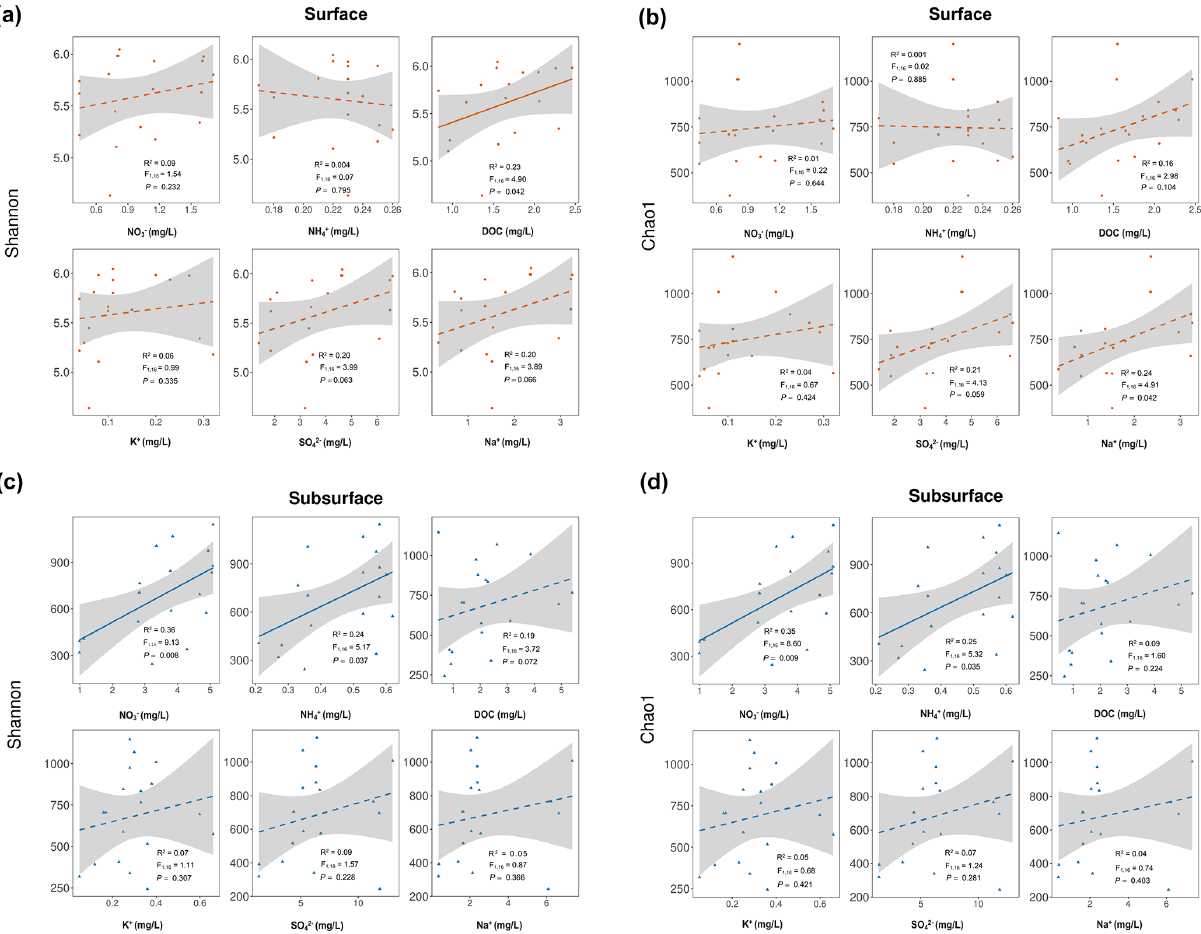
Figure 4. The influence of environmental factors on bacterial diversity. Correlations of Shannon (a, c) and Chao1 (b, d) diversity indices with environmental factors in the surface and subsurface layers. Each dot represents an individual sample. The solid and dashed lines indicate significant and nonsignificant changes, respectively. Significance is based on linear regression. Grey shading indicates the 95% confidence interval of